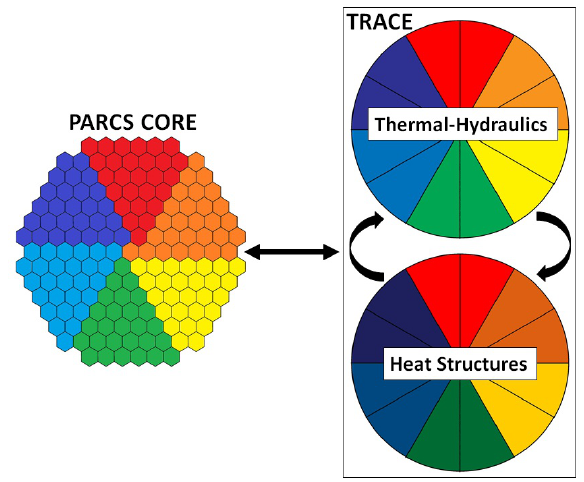
Figure 2. Mapping procedure.